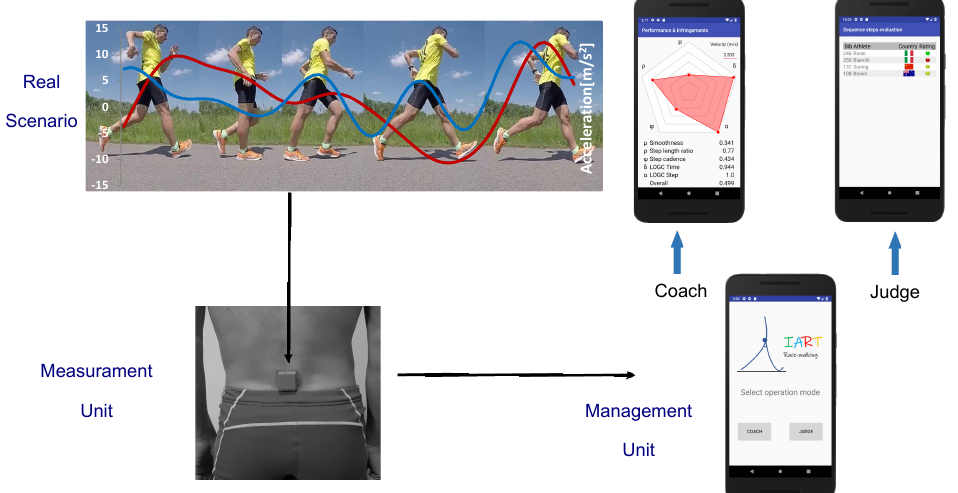
Figure 2. Basic architecture of IART. On the top-left, photo sequence of a real scenario with the acceleration data of CoM (red, vertical; blue, anteroposterior). On the bottom-left, the measurement unit placed at the end of athlete’s column vertebra. On the right, the management unit with a focus on the two modes of functionalities, as shown on the mobile app: coach mode and judge